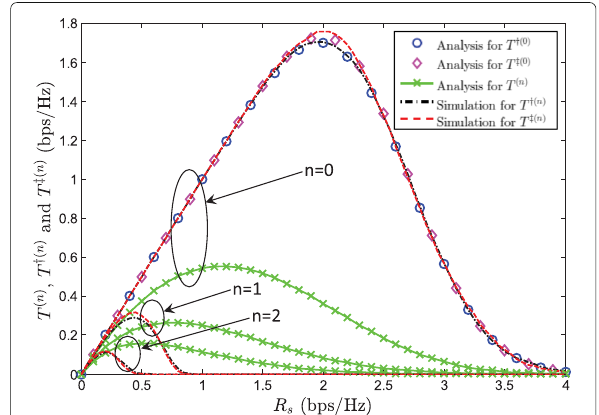
Fig. 6 Simulation results of EST for suboptimal scheme and optimal scheme on basis of SNR = 3 dB